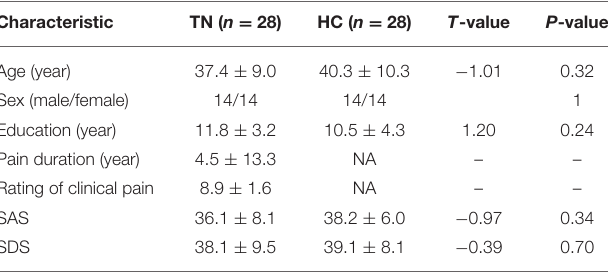
TABLE 1 | Demographic characteristics of the trigeminal neuralgia (TN) patients and the healthy controls (HC).